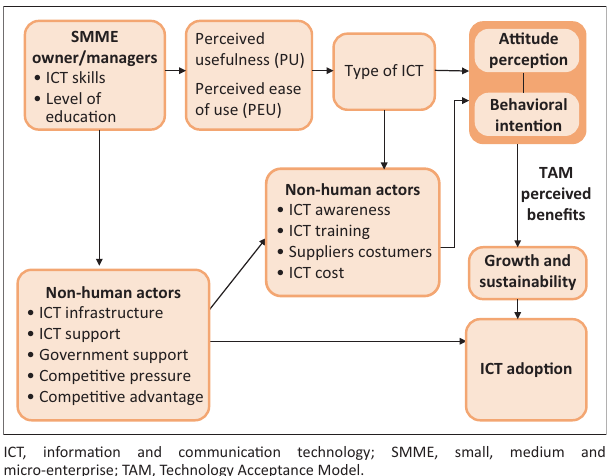
FIGURE 1: Information and communication technology adoption framework for township small, medium and